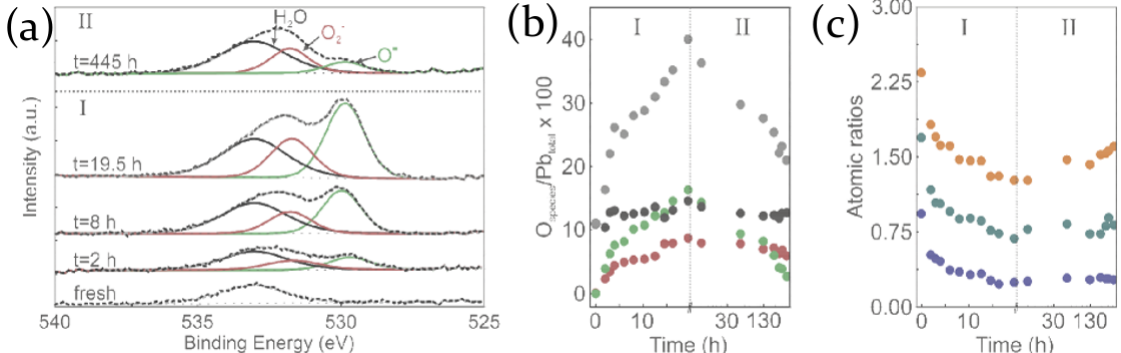
Figure 8. ( a ) Photoelectron energy spectra for ( I ) a photoexcited MAPbBr 3 sample at different times and ( II ) after keeping the sample stored in the dark and in vacuum, with a deconvolution of different oxygen signals. ( b ) Evolution of the O total /Pb total (gray circles), H 2 O/Pb total (black circles), O − /Pb total (red circles) and O 2 − /Pb total (green circles) atomic ratios 2 for the whole experiment, for phases I and II. ( c ) Evolution of the Br/Pb (orange circles), C/Pb (dark green circles) and N/Pb (blue circles) atomic ratios for the whole experiment, for phases I and II. Adapted with permission from [76]. Copyright © 2018, American Chemical Society. https://pubs.acs.org/doi/10.1021/acs.jpclett.8b01830. Further permission should be directed to the